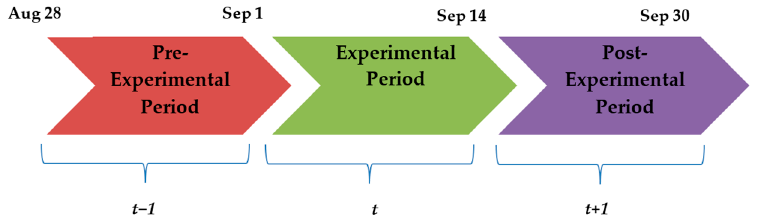
Figure 4. Summer time chart.